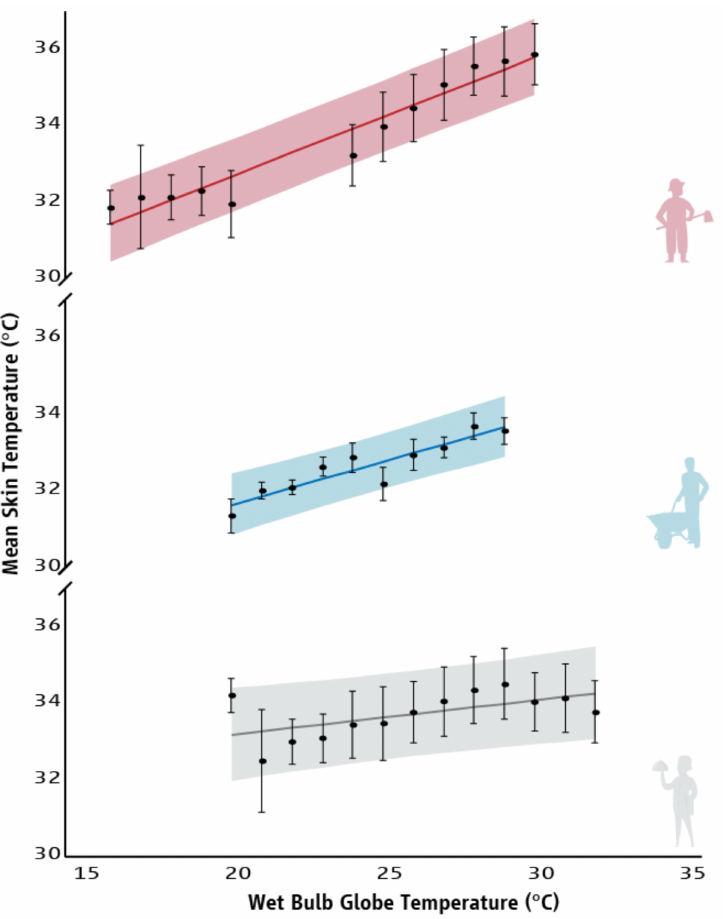
Figure 2. Relationship between Wet-Bulb Globe Temperature and the mean skin temperature (aver- age ± SD) of people who work in agriculture (red), construction (blue), and tourism (grey) sectors. Lines represent the slope of the predicted relationship between Wet-Bulb Globe Temperature and the mean skin temperature of workers. Shadings correspond to the 95% prediction intervals of the